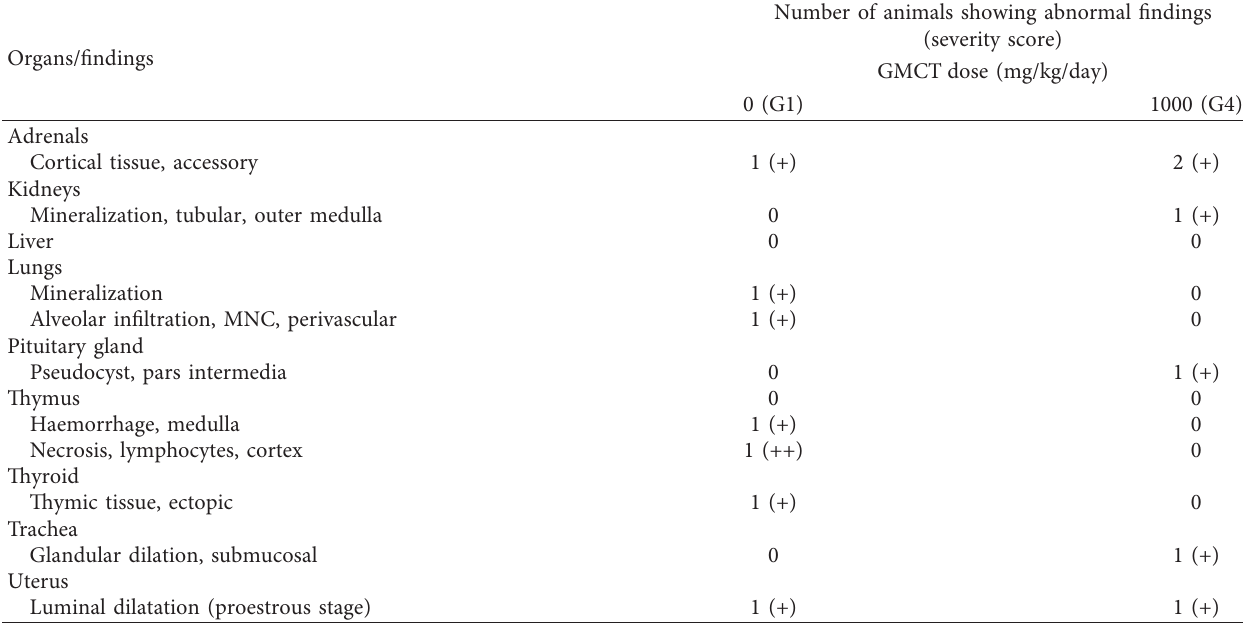
Table 12: Summary of histopathological observations on the vital organs of female Wistar rats after 28 days of oral supplementation of